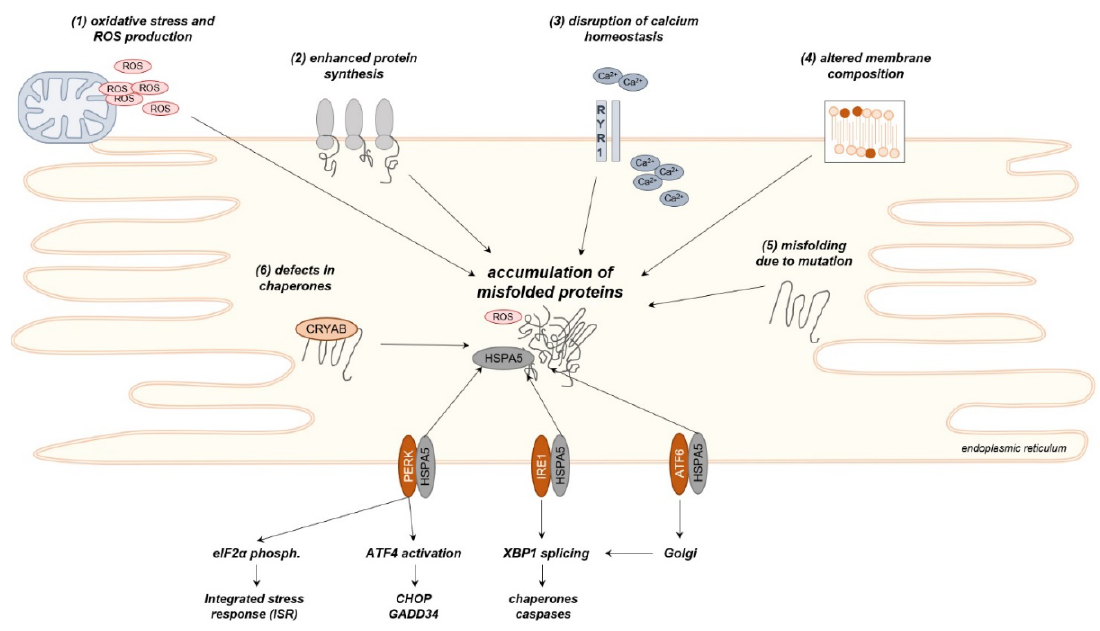
Figure 2. Schematic representation of relevant sources and mechanisms of endoplasmic reticulum (ER)-stress in muscular disorders. A variety of conditions result in the accumulation of misfolded proteins. HSPA5 dissociates from PERK, inositol-requiring protein 1 (IRE1), and activating transcription factor-6 (ATF6) in order to bind to the misfolded proteins, leading to the activation of several downstream pathways. ROS – Reactive Oxygen Species .